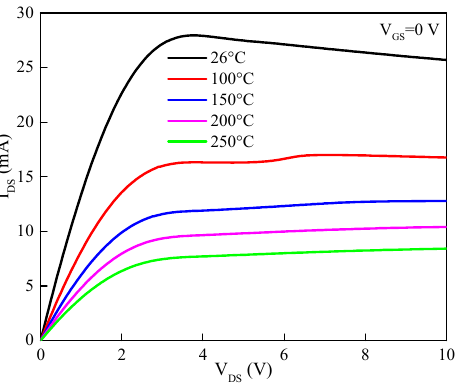
Figure 2. DC output characteristics ( I DS – V DS ) of our Pt-AlGaN/GaN HEMT sensor at different operating temperatures.